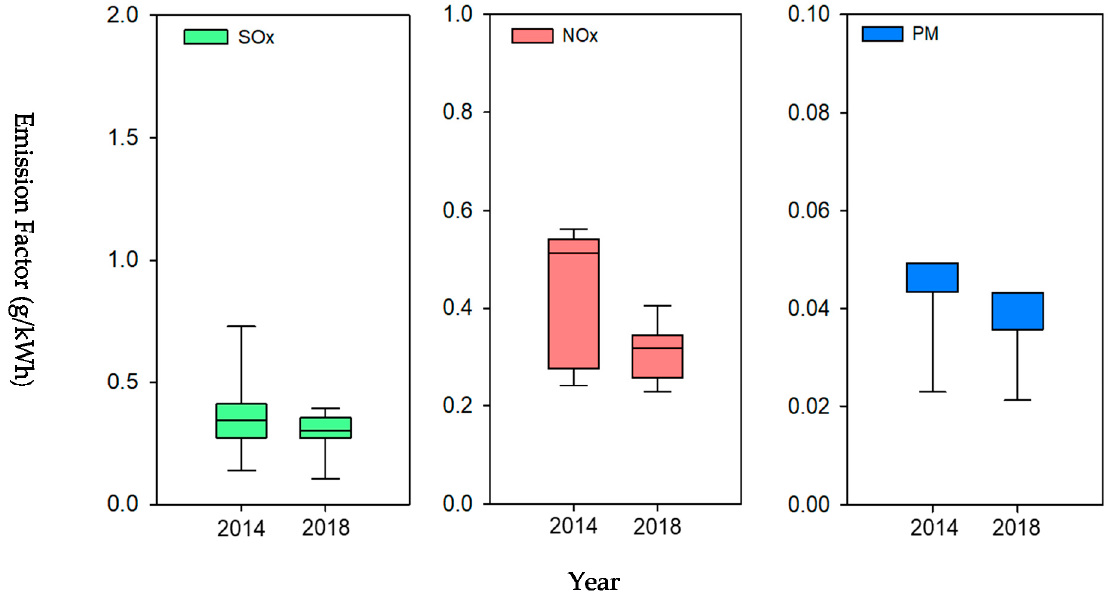
Figure 2. SOx, NOx, and PM emission factors for coal-fired generation units in Taiwan. In 2014, the SO 2 emission factor from each generation unit ranged between 0.105 and 0.742 g/kWh, with an average of 0.362 g/kWh, reflecting a 7.07-fold difference. The emission factor for NOx from each generation unit ranged between 0.235 and 0.566 g/kWh, with an average of 0.428 g/kWh, reflecting a 2.41-fold difference. The PM emission factor from each generation unit ranged between 0.023 and 0.049 g/kWh, with an average of 0.044 g/kWh, reflecting a 2.13-fold difference.